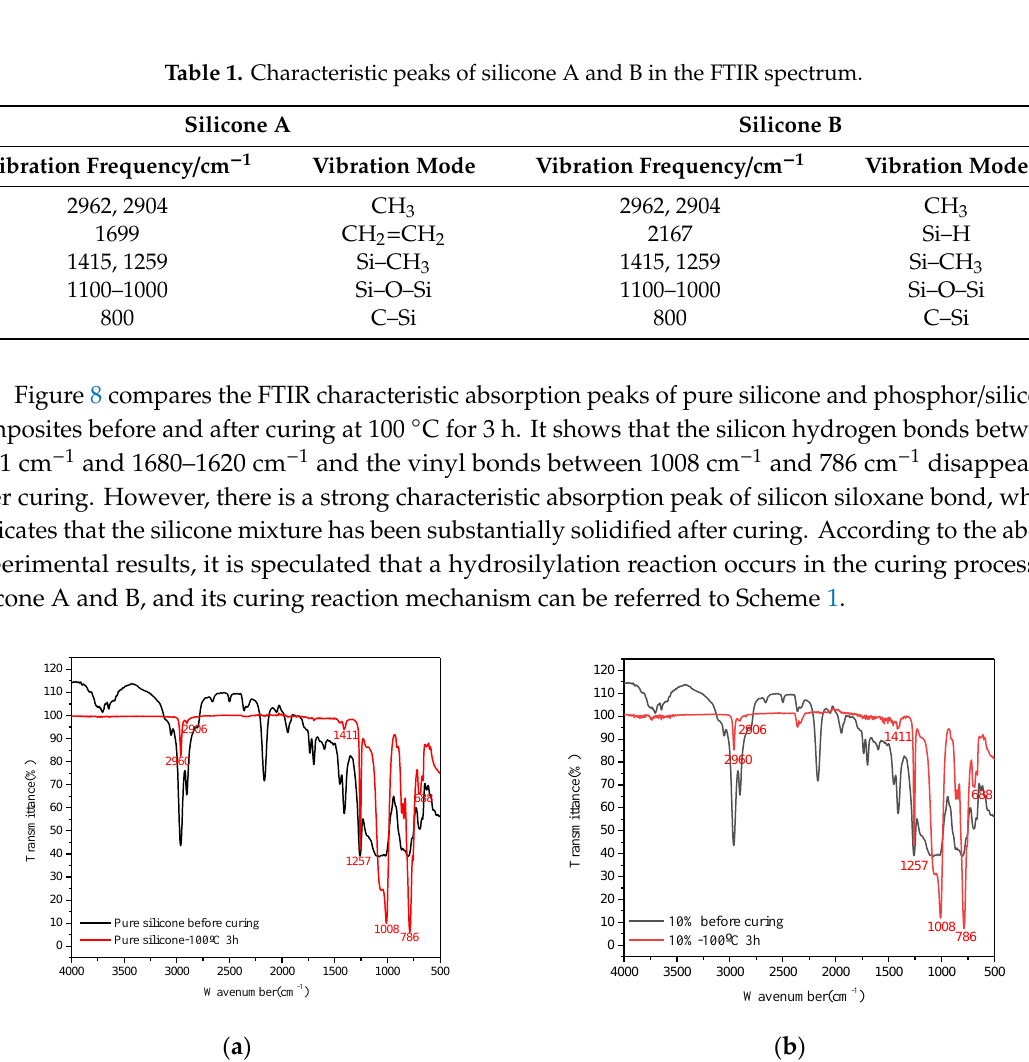
. ( a ) ( b ) Figure 9. ( a ) SEM image of phosphor particles and ( b ) its diameter distribution. Figure 10. FEA modeling and simulation process.